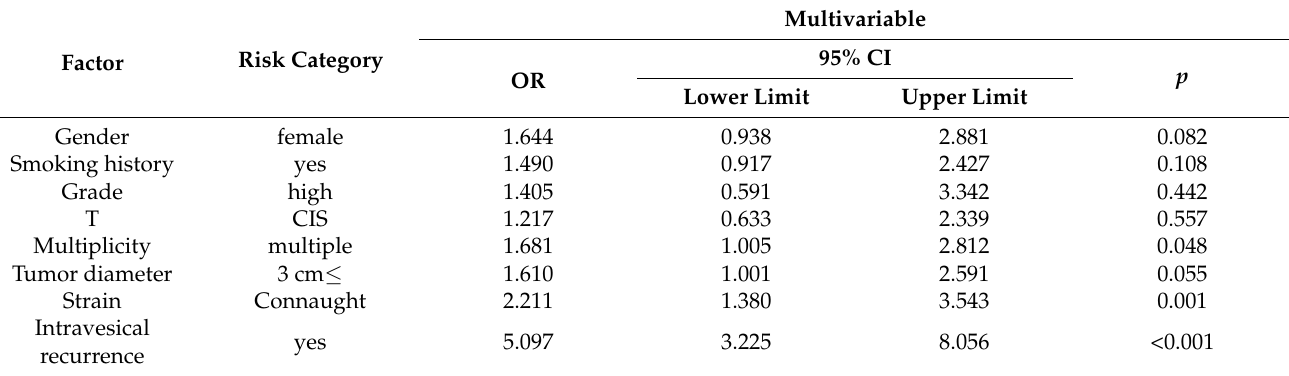
Table 3. Multivariable analysis for elucidating a risk factor of subsequent UTUC by logistic regression